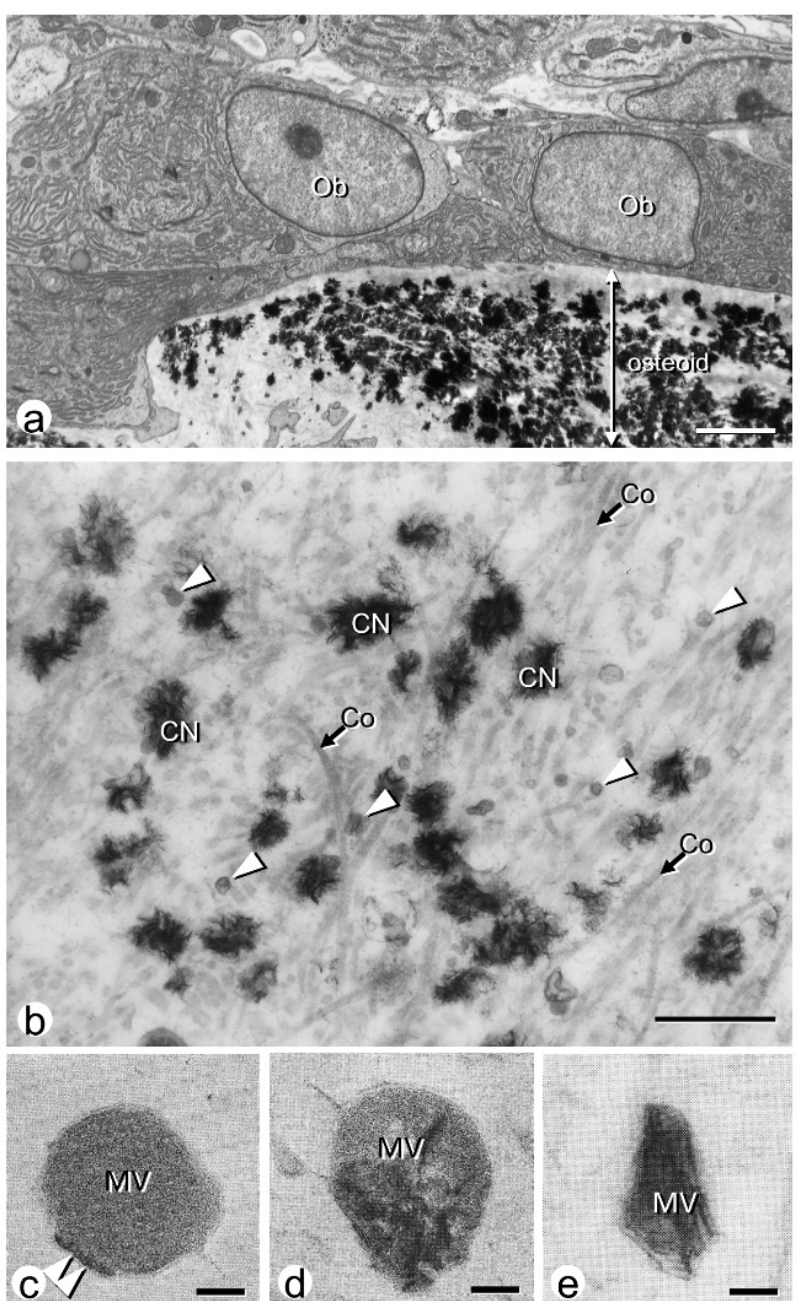
Figure 1. TEM observation of matrix vesicles and mineralized nodules. ( a ) Ultrastructure of osteoid underlying mature osteoblasts (Ob). ( b ) When observed at a higher magnification, there seem to be many matrix vesicles (white arrowheads), mineralized nodules (CN), and collagen fibrils (Co, arrows). ( c ) Amorphous non-crystalline phosphates (arrowheads) are observed along the inner membrane of matrix vesicles (MV) at the early stage of matrix vesicle-mediated mineralization. ( d ) The grown calcium phosphate crystals are seen inside the matrix vesicles. ( e ) The needle-like mineral crystals get out of the matrix vesicles. Panel ( a , b ) are cited from Ref. [19], and ( c – e ) are from Ref. [44]. Reprinted with permission from Ref. [19]. 2018, Springer Nature. Reprinted with permission from Ref. [44]. 1985, Japanese Association for Oral Biology. Bar, 2 mm ( a ), 1 mm ( b ), 30 nm ( c – e ). 2.2. Distribution of Ca and P in the Vicinity of Matrix Vesicles in the Osteoid Electron energy loss spectroscopy, or EELS, enables elemental mapping and can detect calcium (Ca) and phosphorus (P) at an ultra-structural level [45]. A previous report revealed that Ca and P were highly accumulated inside matrix vesicles; however, Ca was evenly and abundantly distributed in the vicinity of the matrix vesicles, while P was detected predominantly in organic materials, such as collagen fibrils and cells, but not in the matrix vesicle vicinity [45]. Nucleation and growth of calcium phosphate crystals require the influx of Ca 2+ and PO 4 3 − inside the matrix vesicles from the extracellular fluid. Taking Ca 2+ and PO 4 3- distribution into consideration, a biological mechanism governing the local synthesis and supplementation of PO 4 3 − , as well as its subsequent influx into matrix vesicles, must be necessary. In contrast to PO 4 3 − synthesis and supplementation, Ca 2+ is abundantly present in the tissue fluid, and annexins, which are acidic phospholipid-dependent Ca 2+ -binding proteins, are assumed to serve as the